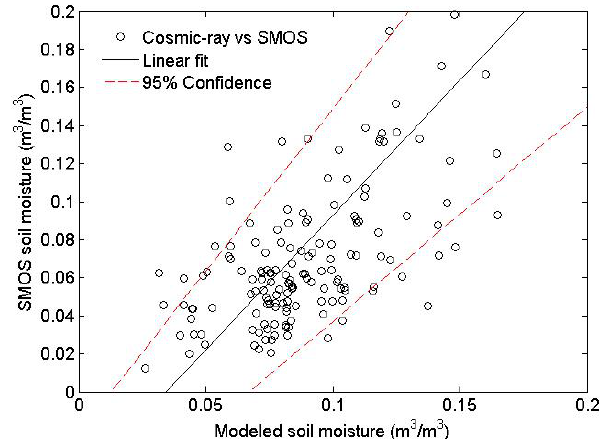
Fig. 8. Correlation of the area-average SMOS Level 3 soil mois- ture product with the interpolated cosmic-ray soil moisture values. The correlation is described here with and linear relationship. The SMOS product has a significant degree of noise ( ∼ 0.04m 3 m − 3 ) , and in consequence was reprocessed with this correlation. The scat- ter is attributed to satellite noise and uncertainties in the interpola-